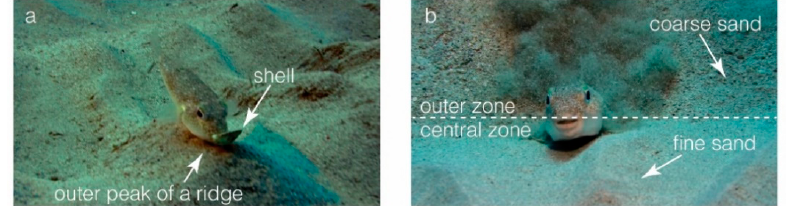
Figure 16. Sand grain distribution within the nest. ( a ) The pufferfish can be observed picking up